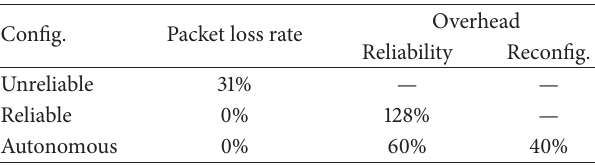
Table 1: Comparison between static and self-aware configurations over 140 seconds [6].